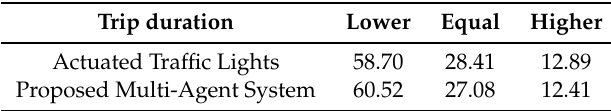
Table 2. Results summary (Percentage of total